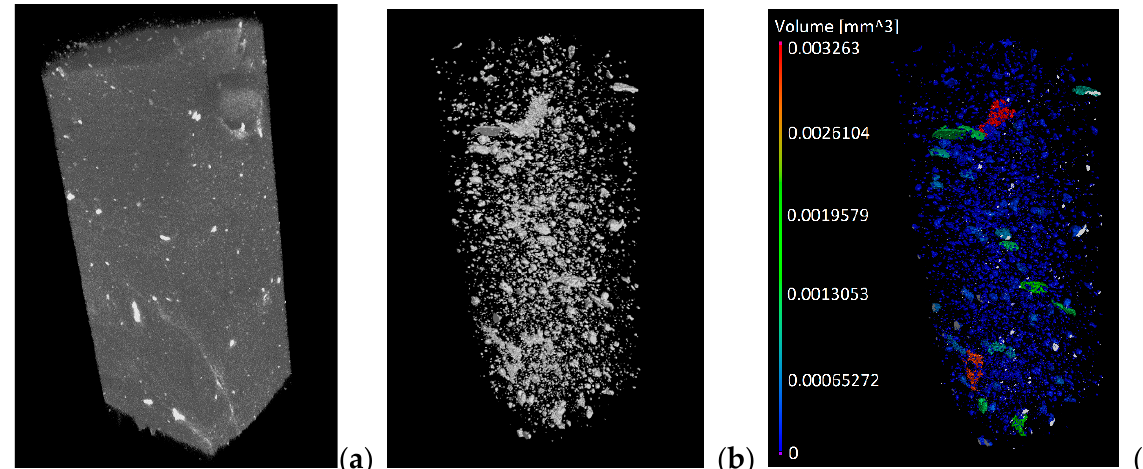
Figure 9. For a selected sample with 60% inclusion of HA particles, an overview of ( a ) the reconstructed volume, ( b ) isolation of HA particles, and ( c ) quantification of HA particles.